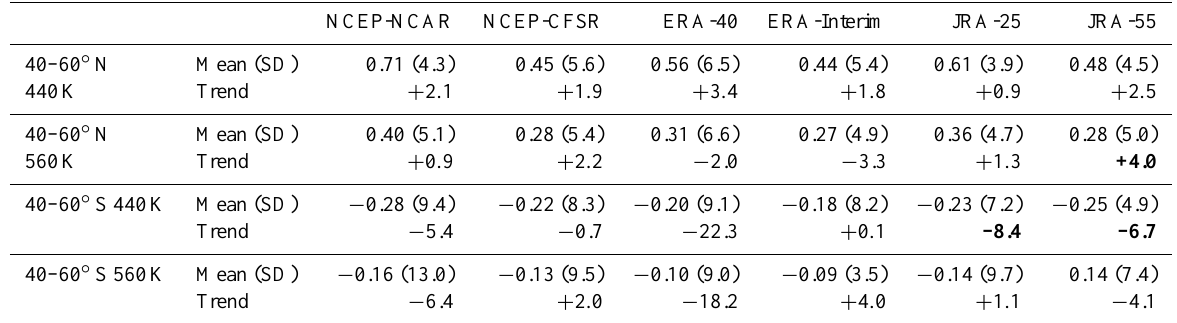
Table 3. Same as in Table 1, but for the mass stream function (in 10 10 kgs − 1 ) averaged over 40–60 ◦ N in DJF, and over 40–60 ◦ S in JJA at 440 and 560K. The linear trend with a confidence level greater than 95% is shown in bold.